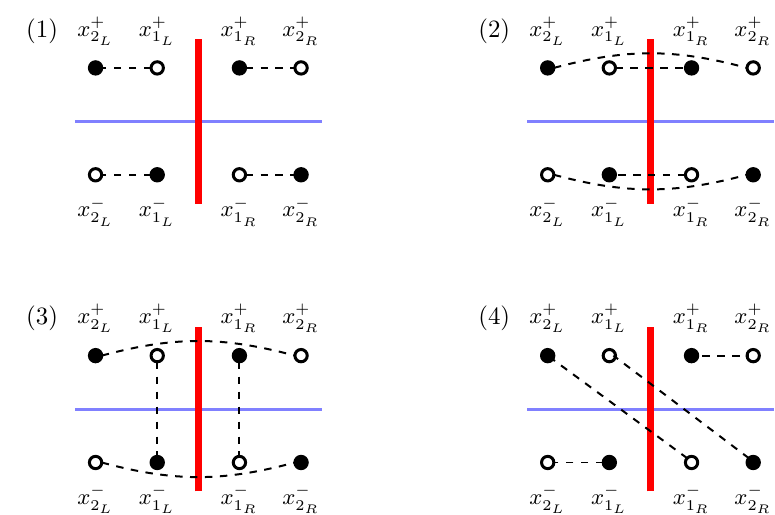
Figure 7 . Examples of competing channels for the two-interval Rényi entropy in the TFD state. The last two figures illustrate partially disconnected channels that are associated with island contributions in the black hole